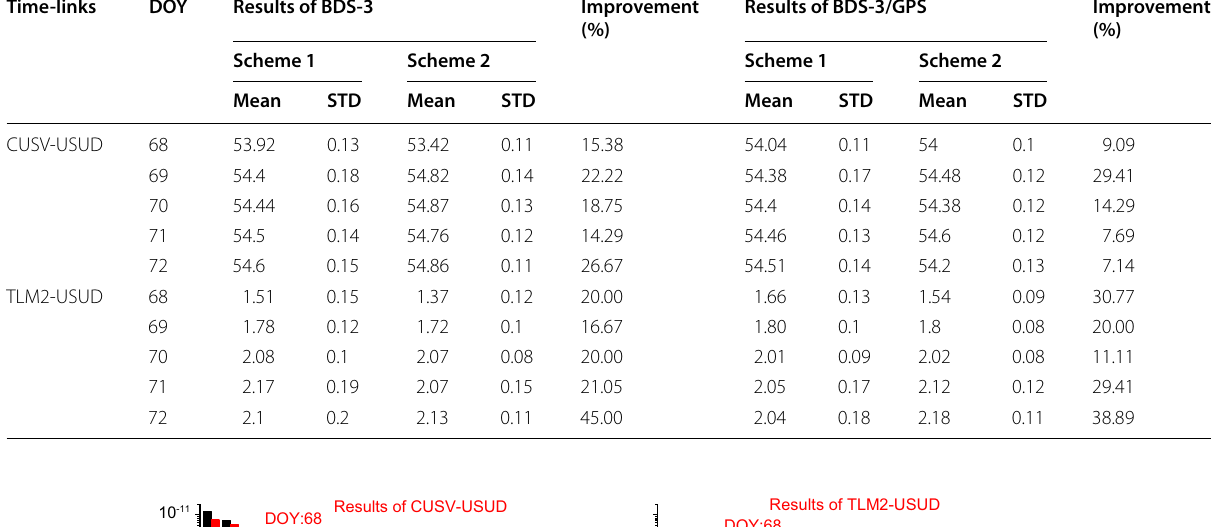
Table 3 Mean and STD of the difference between the time transfer solutions calculated from BDS-3 and BDS-3/GPS PPP in Scheme 1 and Scheme 2 (ns) and the PPP time transfer with IGS final products. Note that (%) indicates the improvement of Scheme 2 compared to Scheme 1 for the STD values